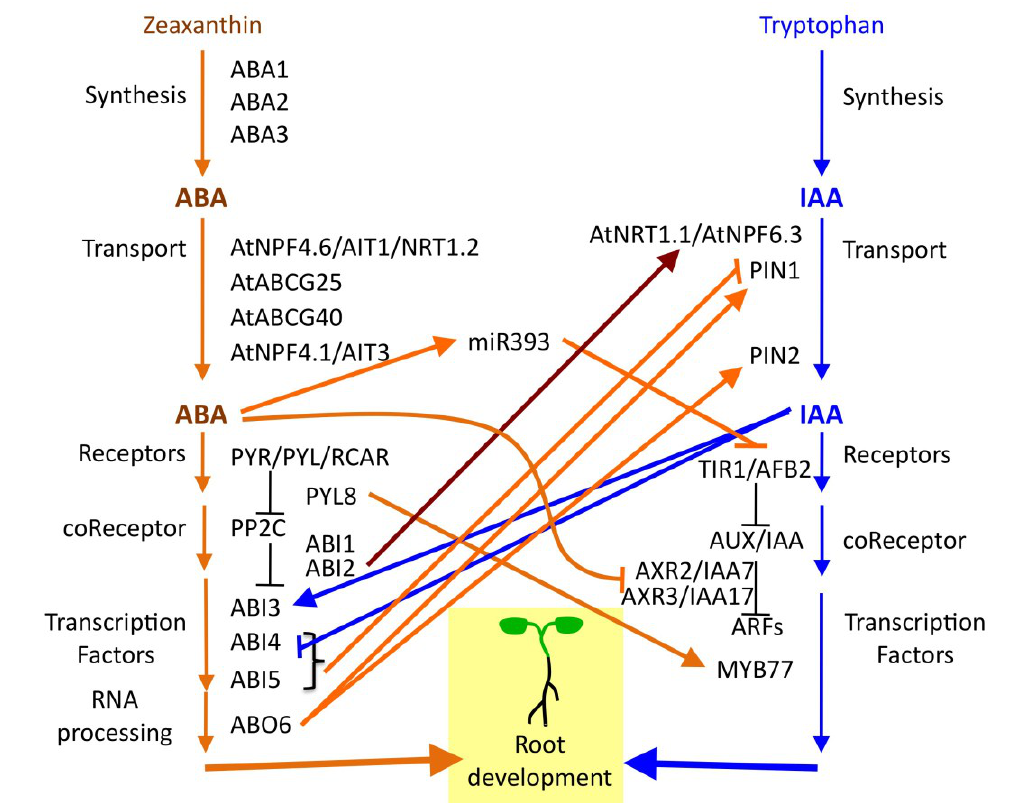
Figure 2. Interactions between ABA and auxin signaling pathways during elaboration of the Arabidopsis root system. This diagram is restricted to genes mentioned in the text and does not include all ABA or auxin signaling genes. Downward arrows do not imply a simple linear pathway, but are rather used to group genes according to function. Crosstalk between the ABA and auxin signaling pathways are indicated by arrows, signifying a positive interaction, and blocked lines, signifying a negative interaction. When evidence for crosstalk is based on treatment with exogenous ABA or IAA, and a specific gene mediating this activity is unknown, the arrows originate from the hormone name, rather than a gene name. Orange arrows indicate interactions originating from the ABA pathway. Blue arrows indicate connections originating from the Auxin pathway. The red arrow indicates a connection between ABA and Auxin signaling components that may be independent of their function in ABA or Auxin signaling. ABI2 regulates the nitrate transport function of AtNRT1.1/AtNPF6.3, but its effect on auxin transport is unknown [97]. AtRAC7/ROP9 is not included in this diagram, although it is clearly involved in ABA/Auxin crosstalk, because its role connecting these pathways may be context dependent